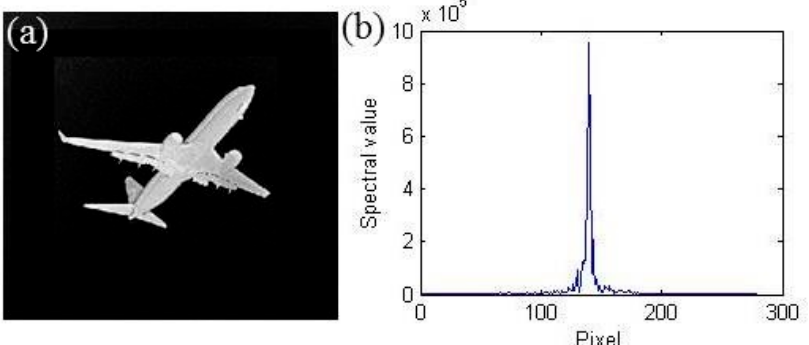
Figure 6. ( a ) Light intensity distribution of the source; ( b ) airplane image spectrum center slice.